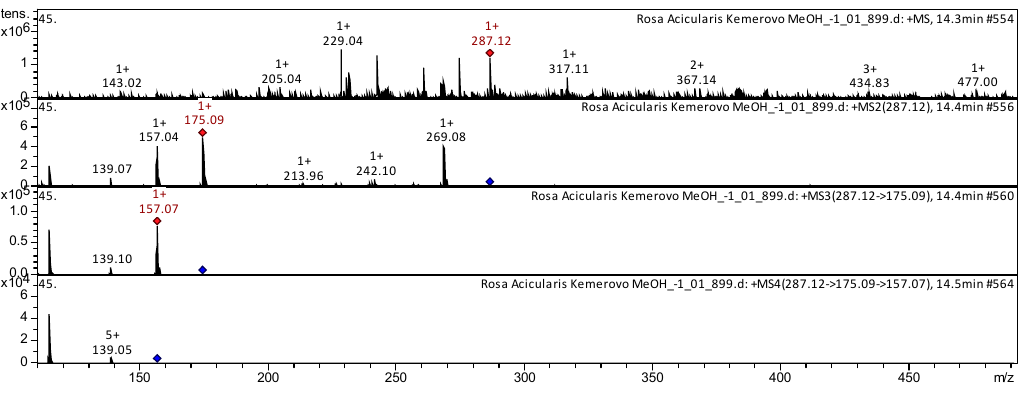
Figure 7. CID-spectrum of Kaempferol from extracts of R. acicularis , m / z 287. The [M + H] + ion produced six fragment ions at m / z 269, m / z 242, m / z 213, m / z 175, m / z 157, and m / z 139 (Figure 7). The fragment ion with m / z 175 yielded two daughter